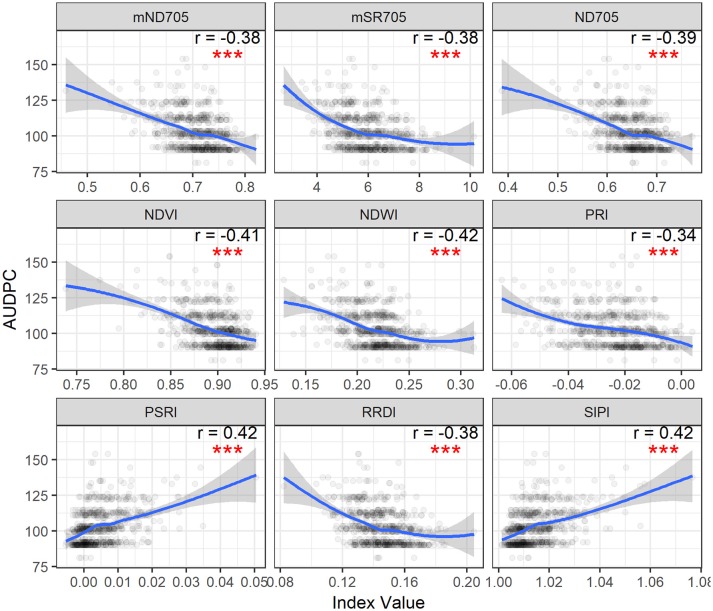
Area under disease progress curve (AUDPC) of visual scores plotted as a function of spectral indices. Correlation coefficients (r) are for the Spearman's correlations between the spectral indices and AUDPC of STB scores (***p < 0.001). Loess fit lines are added to the scatter plot to show the trend of the relationship. Results are based on the data of the whole population (335 varieties) used in the main experiment.